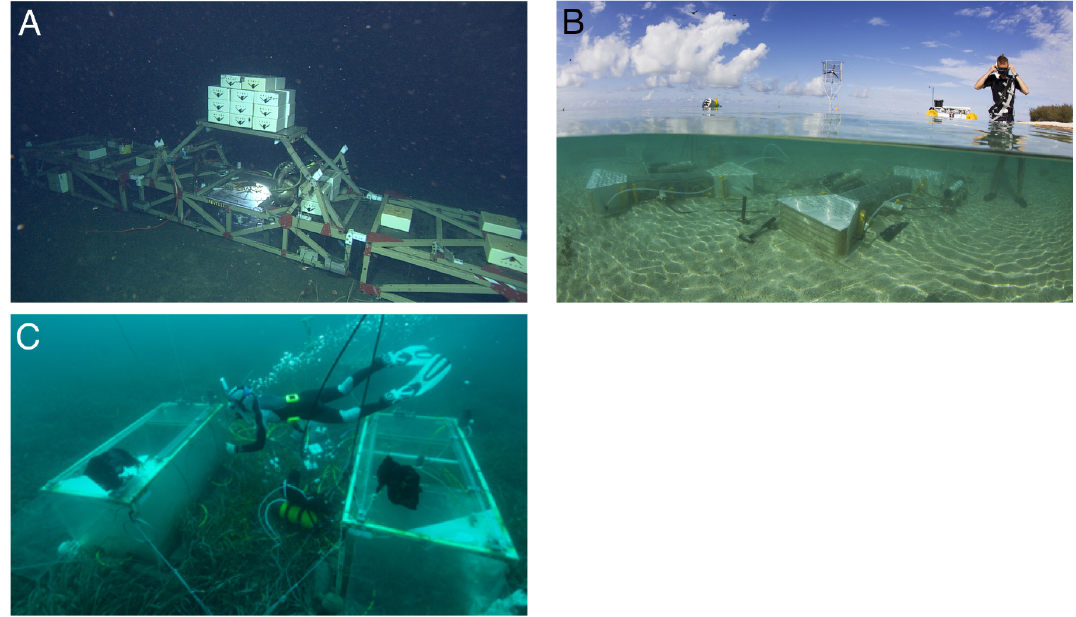
Figure 4. (A) Deep-water FOCE (dpFOCE), (B) Coral Proto FOCE (cpFOCE), and (C) European FOCE (eFOCE). Credits: (A) MBARI, (B, D, I) Kline (Scripps Institution of Oceanography), and (C, D) Luquet